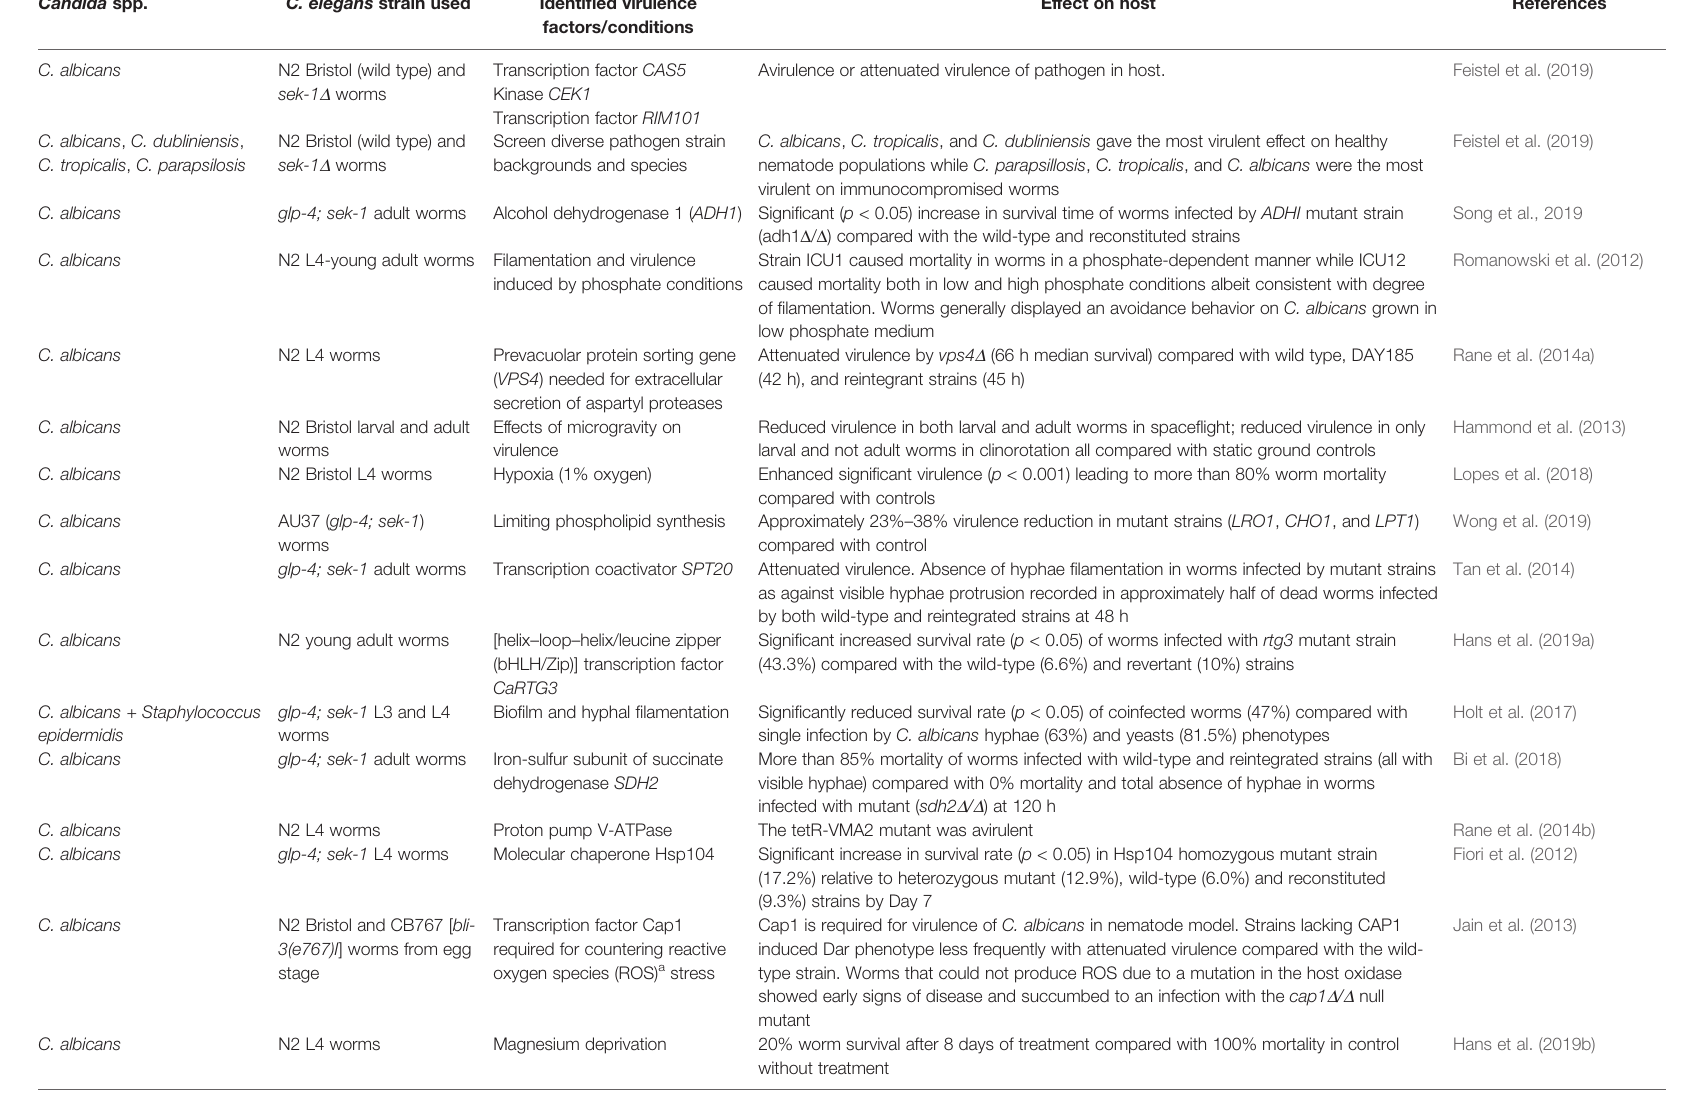
TABLE 1 | Application of C. elegans in determining/con fi rming in vivo virulence of Candida spp. Candida